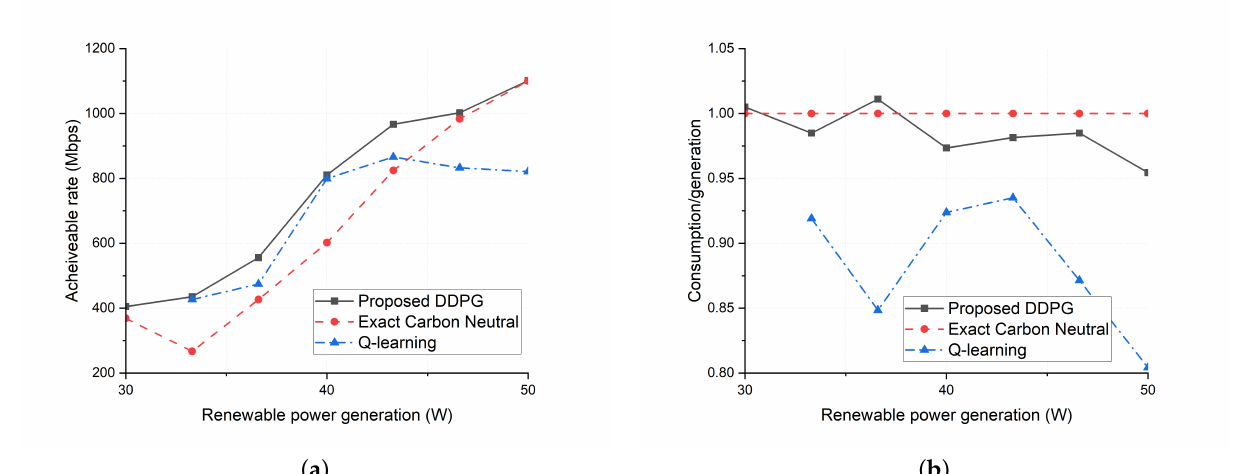
Figure 6. Comparison of performances among different schemes after training. ( a ) Achievable rate and ( b ) ratio of power consumed to power generated by